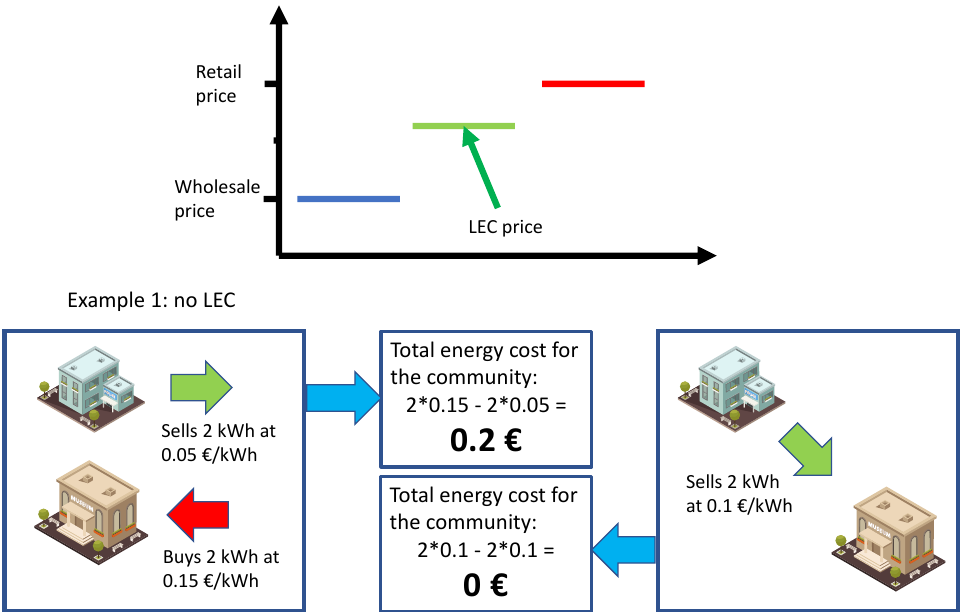
Figure 3. An example of energy buy and sell prices into an LEC, compared with buying and selling energy to the main